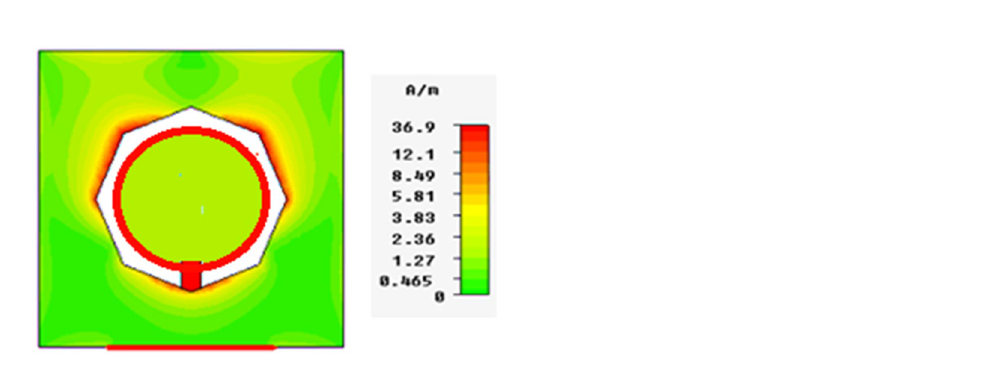
Figure 16. Magnetic intensity distributions for Antenna4 at the fundamental resonance of 2.74 GHz.